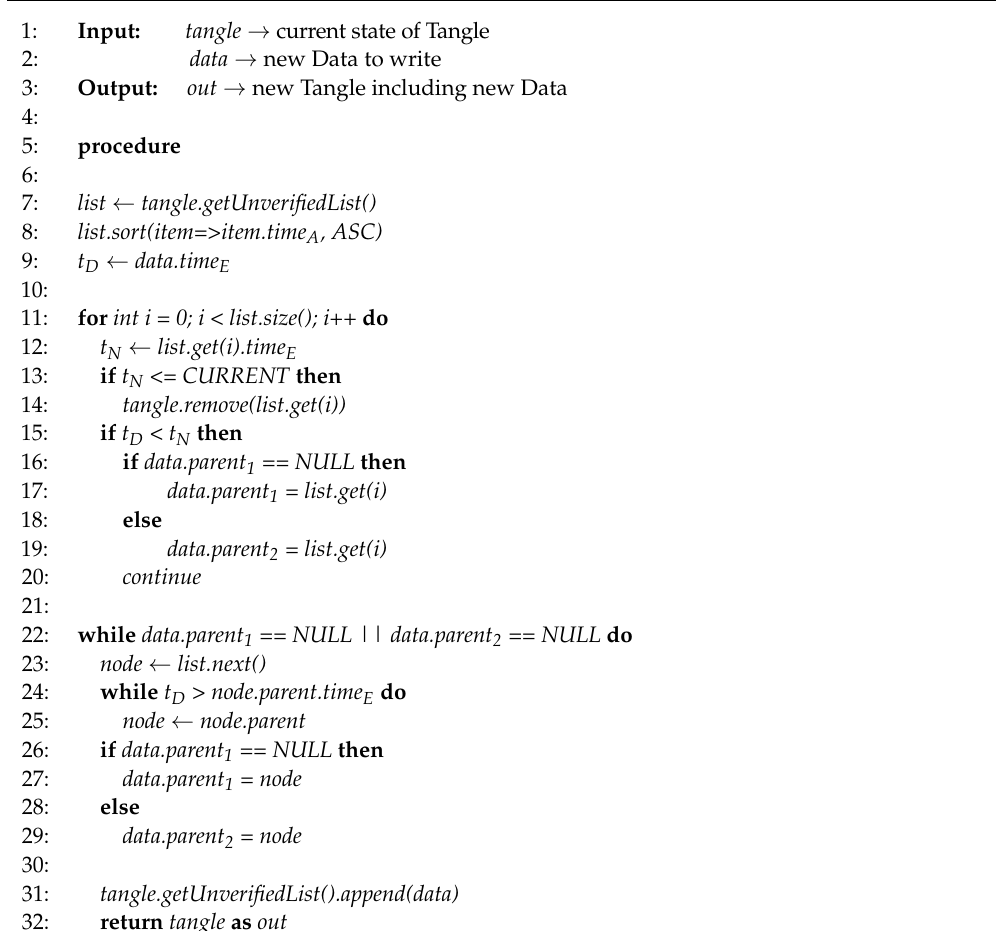
Algorithm 1. Climb-up write